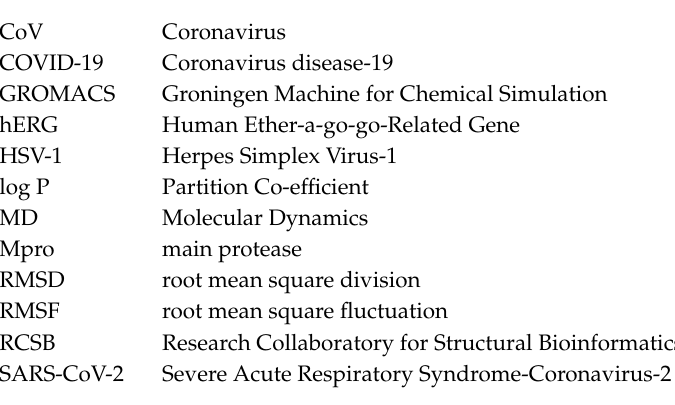
Supplementary Materials: The following are available online, Figure S1: Ramachandran plot of SWISS-Model- predicted structure of TMPRSS2, 92.7% favored region. 6.7% allowed region and 0.6% outlier region.Figure S2: RMSD plot of protein and protein-ligand complexes, (A) Mpro and (B) TMPRSS2. Figure S3: RMSF plot of protein and protein-ligand complexes, (A) Mpro and (B) TMPRSS2. Figure S4: SASA plot of protein and protein-ligand complexes, (A) Mpro and (B) TMPRSS2. Figure S5: Rg plot of protein and protein-ligand complexes, (A) Mpro and (B) TMPRSS2. Table S1: Predicted molecular properties of the Compounds.Table S2: Predicted Absorption parameter of the compounds. Table S3: Predicted Distribution and Excretion parameter of the compounds. Table S4: Predicted metabolism parameter of the compounds. Table S5: Predicted docking score of ligands with TMPRSS2 by PyRxVina and DockThor software. Table S6: Predicted docking score of ligands with Mpro by PyRxVina and DockThor